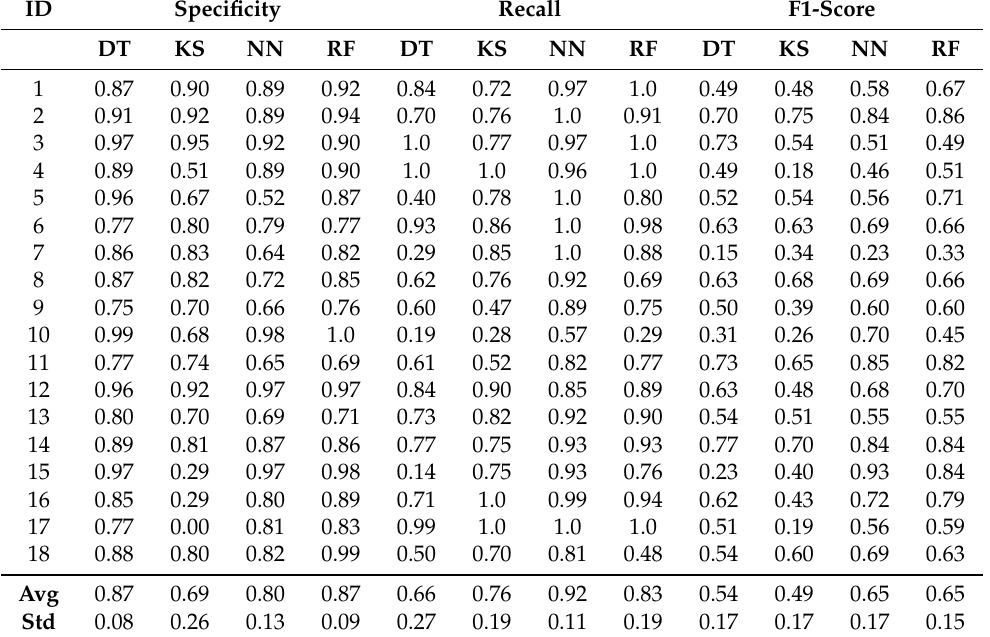
Table 3. Classification results by algorithms using 12